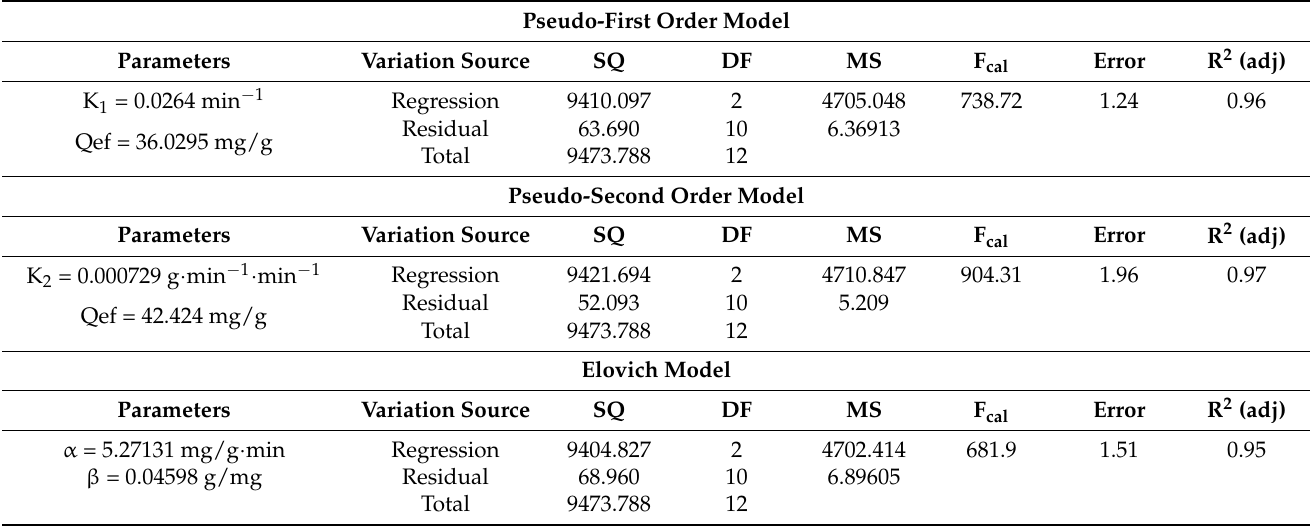
Table 8. Kinetic parameters and ANOVA obtained experimental data of SD adsorption in acid- functionalized sample fitting to the models of pseudo-first-order, pseudo-second-order and Elovich.